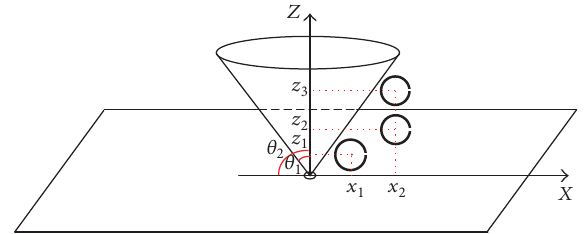
Figure 3: Geometry of a split loop and its equivalent circuit.